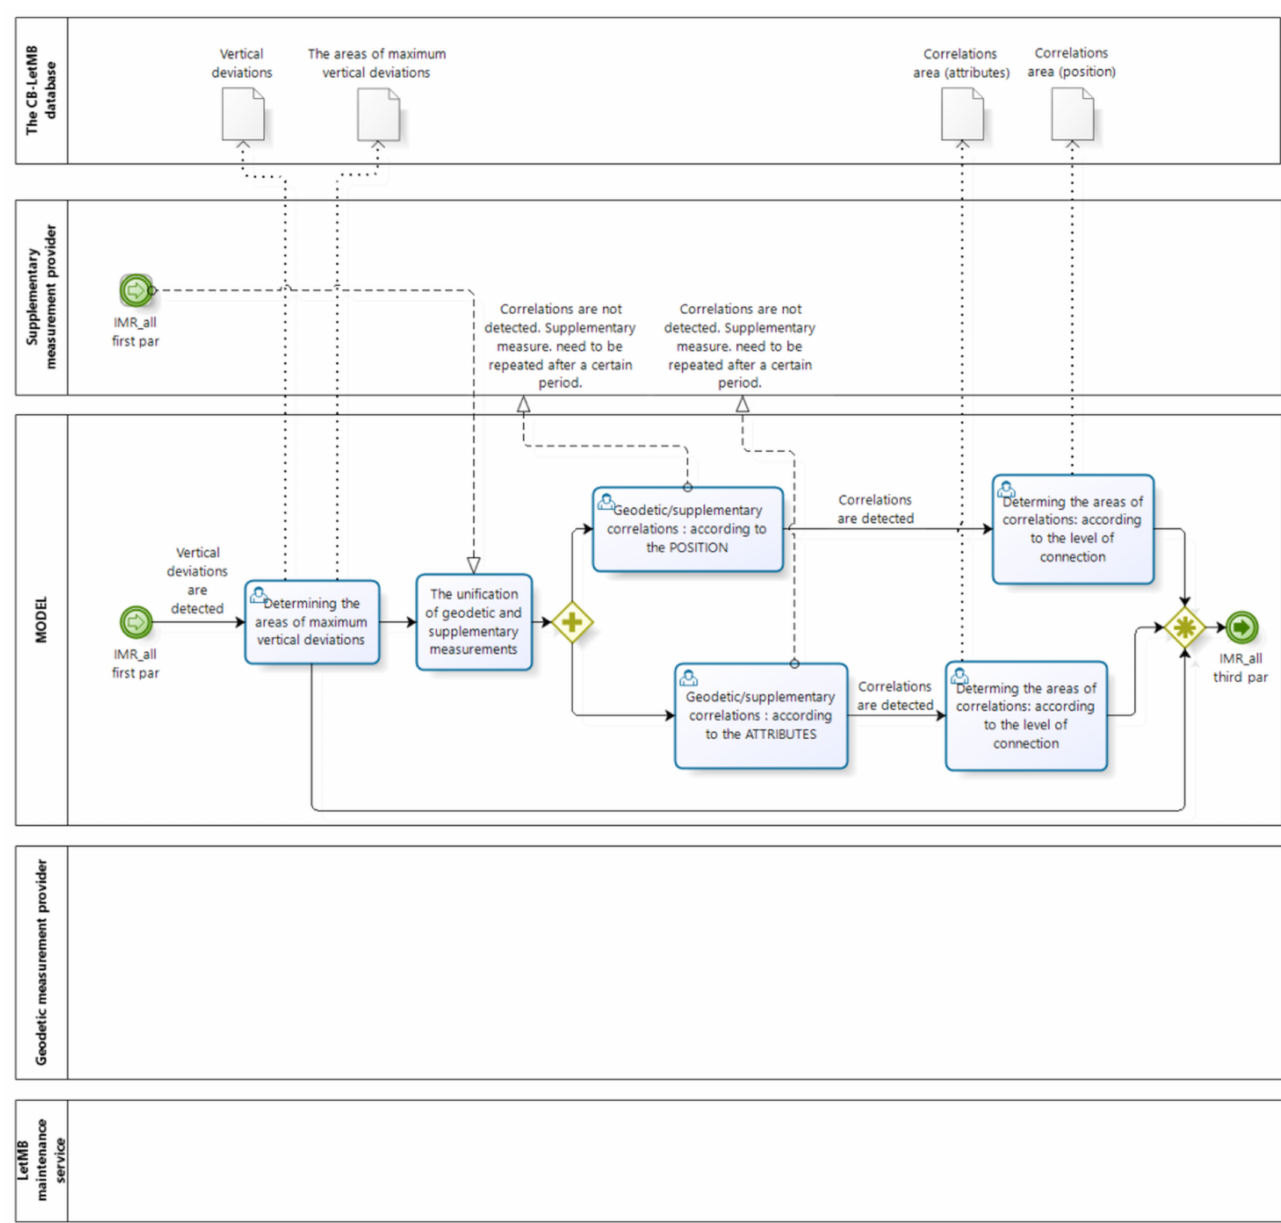
Figure 9. Second part of BPD’s process decision-making maintenance model